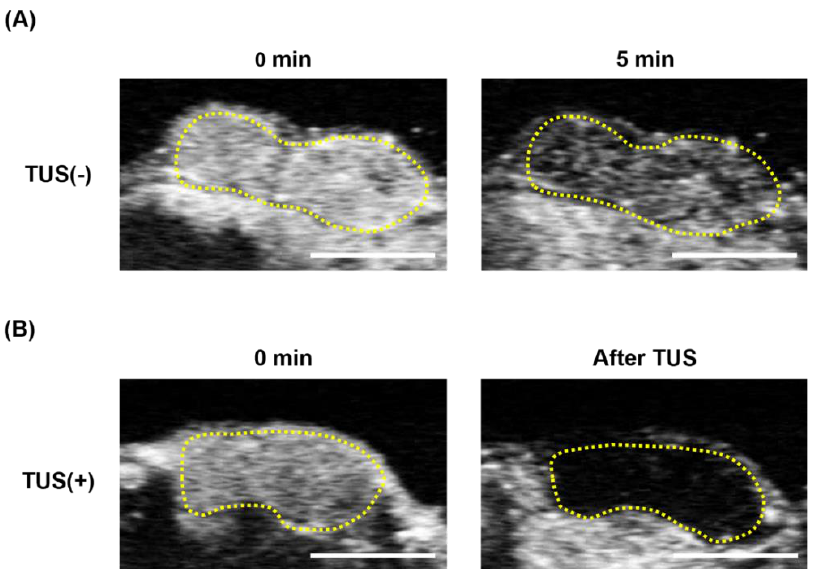
Figure 4. Ultrasonography images of Her-NBs with/without TUS groups in tumors in vivo. SKOV3- bearing mice (Tumor volume: approximately 200–300 mm 3 ) were injected with Her-NBs intra- venously, and contrast images of the tumors were captured. The tumor was exposed to TUS (fre- quency, 1 MHz; duty, 50%; intensity, 1 W/cm 2 ; time, 2 min) immediately after injection in the TUS-exposure groups. Contrast images of ( A ) Her-NBs without TUS from 0 min to 5 min and ( B ) Her-NBs with TUS at 0 min and immediately after TUS exposure. Images were captured by US diagnostic machine with a 12 MHz probe. The circles show the area of the tumor. Scale bar: 5 mm.